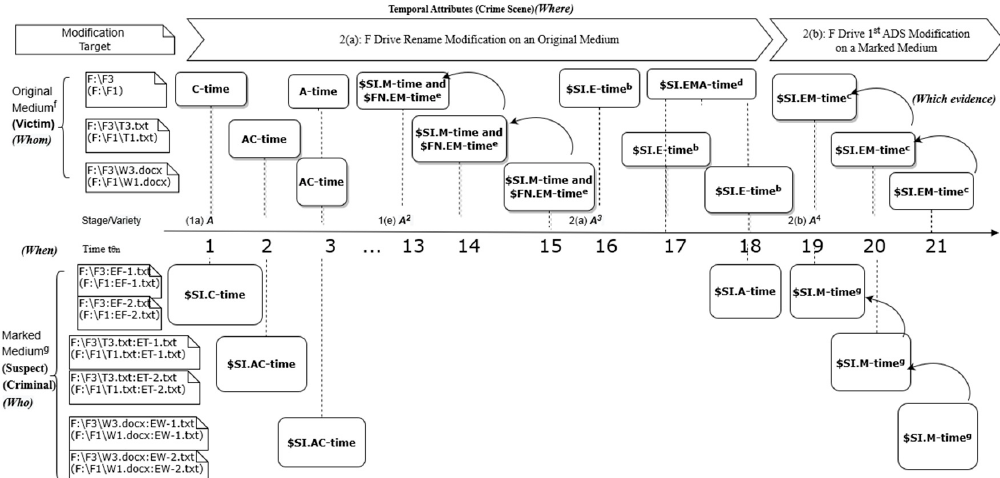
Figure 3. Temporal reconstruction on modification timeline (Stage 2). Note: b Rule 2, c Rule 3, d Rule 4, e Rule 5, f Rule 6, and g Rule 7.